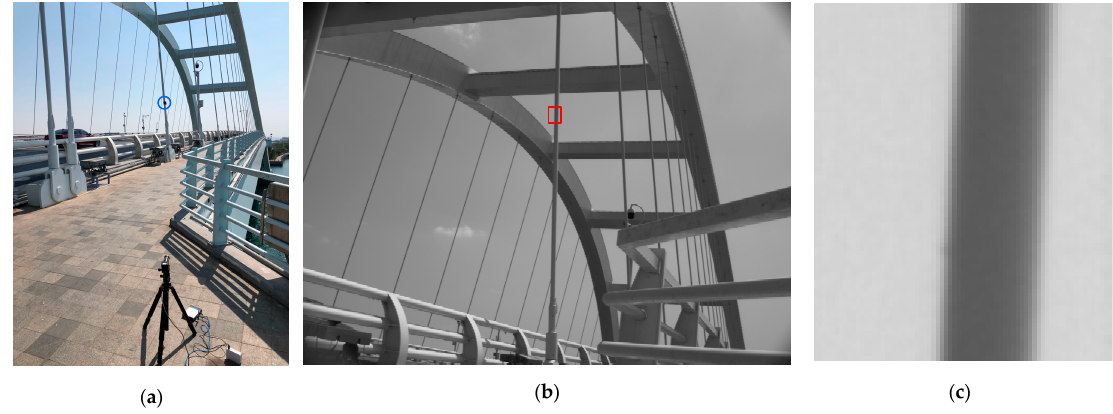
Figure 6. Field experimental setup: ( a ) Camera, receiver, vibrometer (highlighted in blue circle); ( b ) Field of view of the camera (ROI highlighted in red rectangle); ( c ) ROI for vibration frequency measurement.